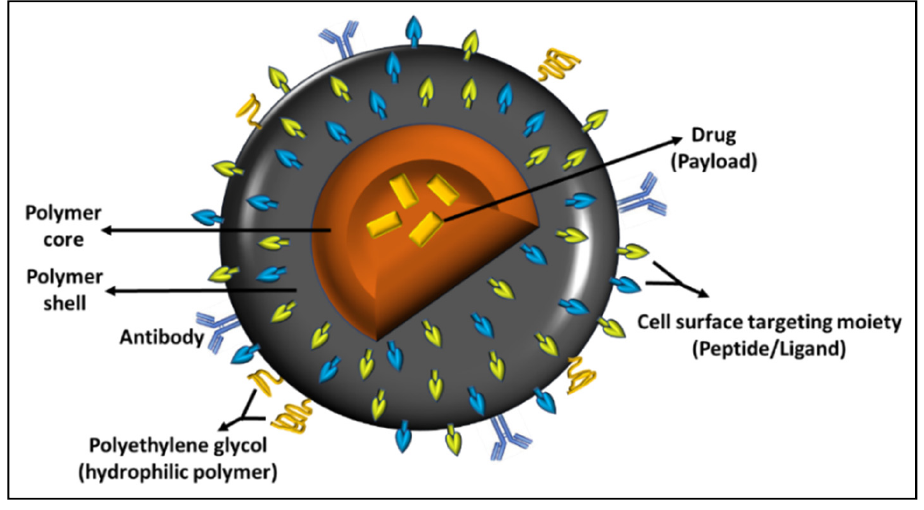
Figure 2. Rectal cancer treatment polymer nanoparticles.